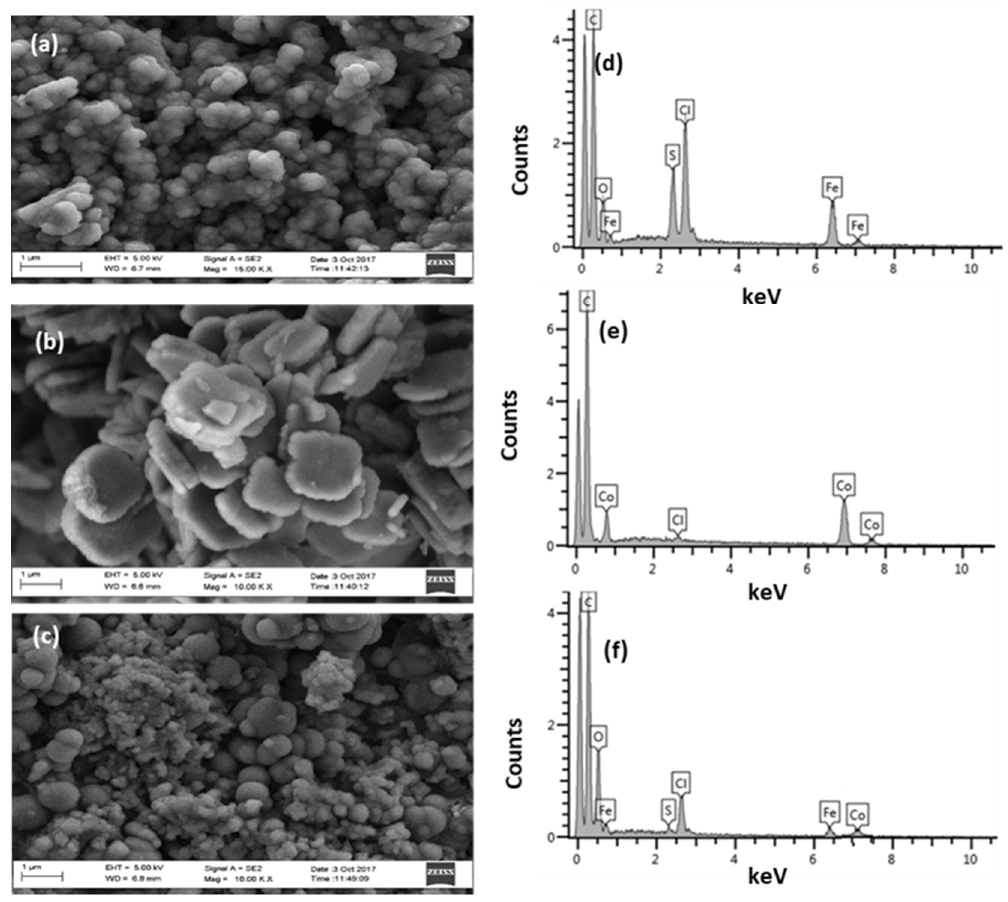
Figure 3. SEM images of ( a ) PABA, ( b ) CoZIF and ( c ) the PABA / CoZIF composite, and EDS spectra of ( d ) PABA, ( e ) CoZIF and ( f ) the PABA / CoZIF composite.